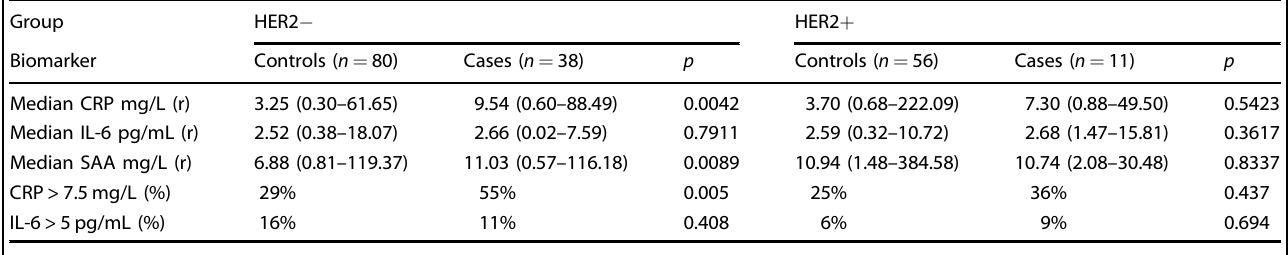
Table 2. Biomarker concentrations by case status and HER2 status.